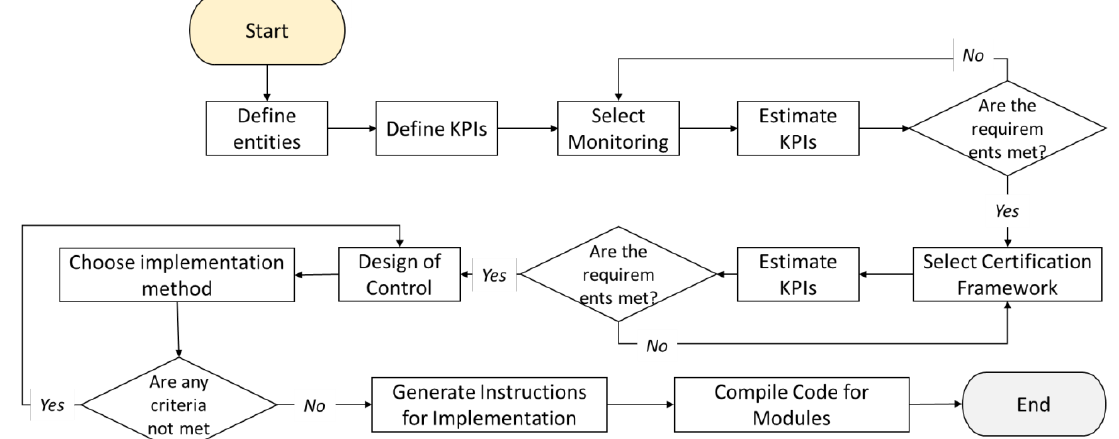
Figure 6. Workflow for process monitoring/control.